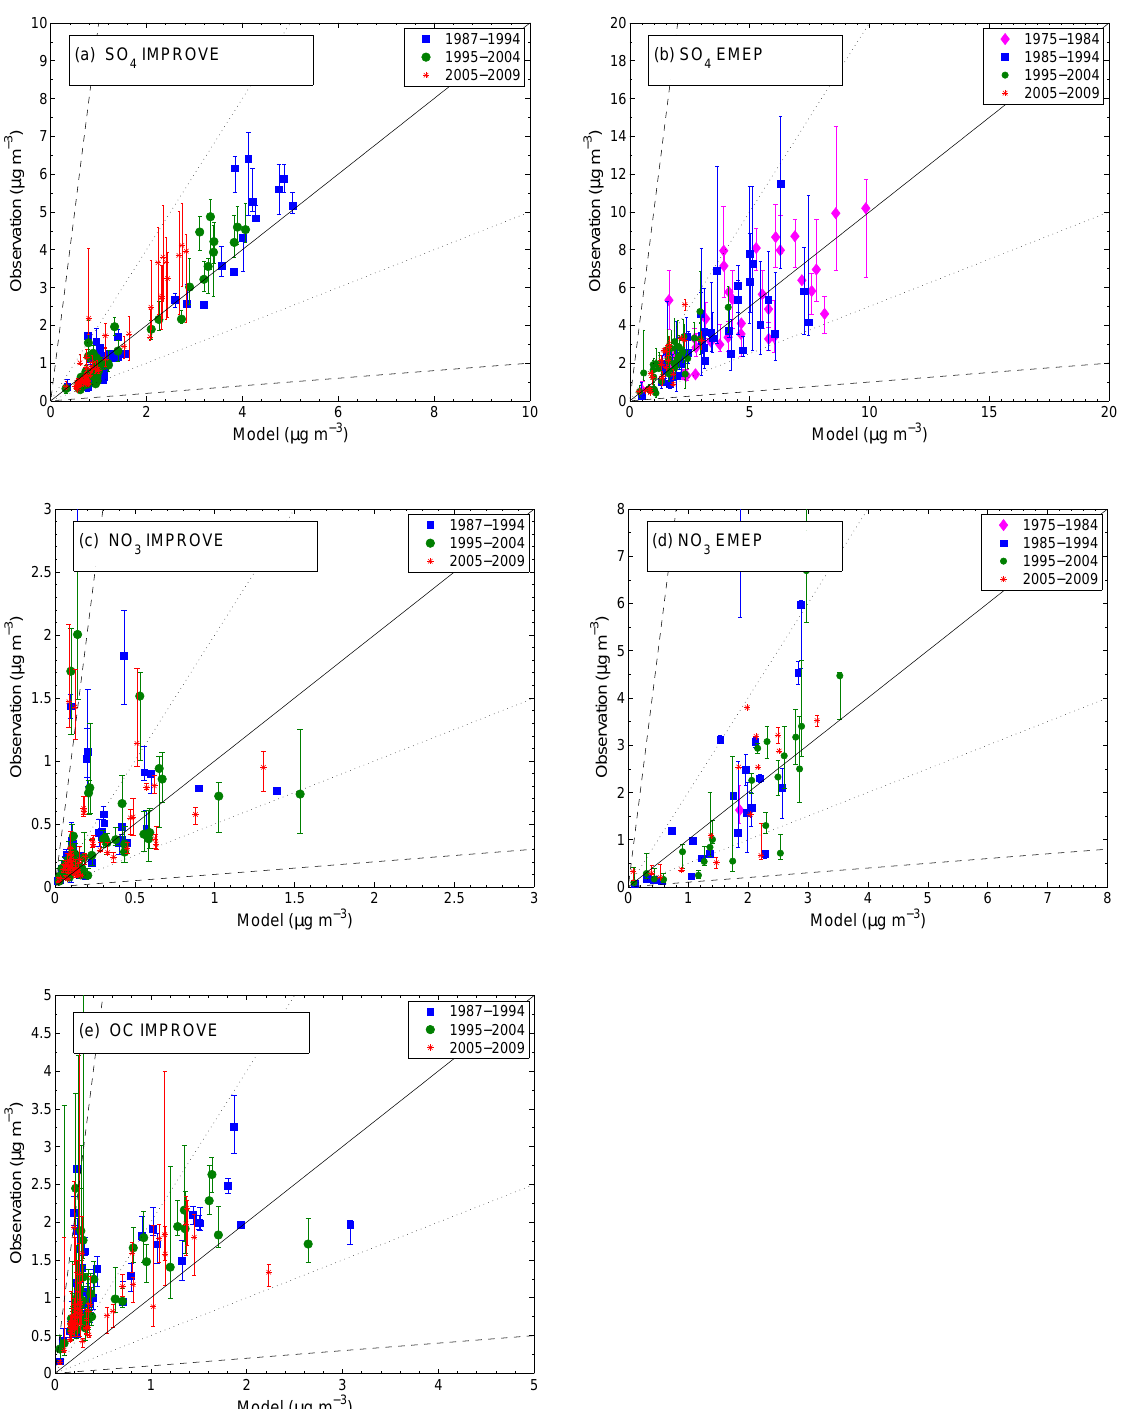
Fig. 10. The median of the observed annual means from the IMPROVE and EMEP networks compared with the corresponding modelled annual means for sulphate (a, b) , nitrate (c, d) and OC (e) for each decade. The solid line shows a one-to-one correspondence. The dotted lines show a factor of 2 difference and the dashed lines a factor 10 difference between the observations and model results. The error bars added to the observations denote the maximum and minimum of the annual means in the decade.